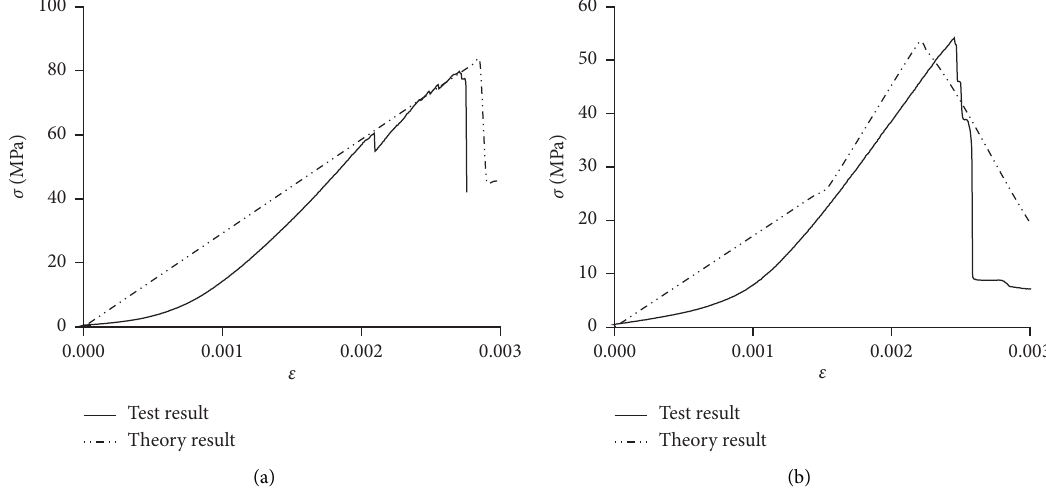
Figure 14: Experimental and theoretical stress-strain curves under dry and saturated conditions. (a) DRY 3. (b) SAT 1.